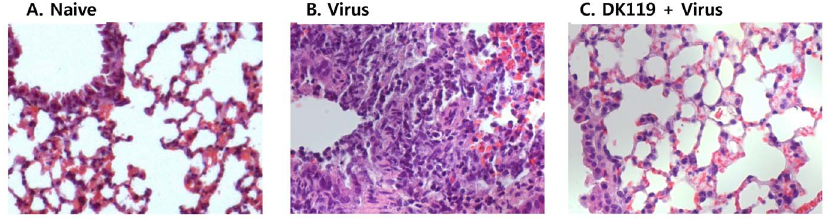
Figure 9. DK119 pretreatment reduces influenza virus-induced lung histopathology. Inflammatory histopathology after H&E staining of lung sections was compared from mice that were infected with influenza A/PR8 virus (H1N1) with or without DK119 treatment. (A) Naı¨ve: Naı¨ve mice without A/PR8 virus and DK119, (B) Virus: mice that were infected with A/PR8 virus without DK119 treatment, (C) DK119 + Virus: DK119 (10 7 ) intranasal pretreatment and then A/PR8 virus infection in the presence of DK119 (10 9 ). All images were obtained using the same camera setting and shown at a magnification of X400.